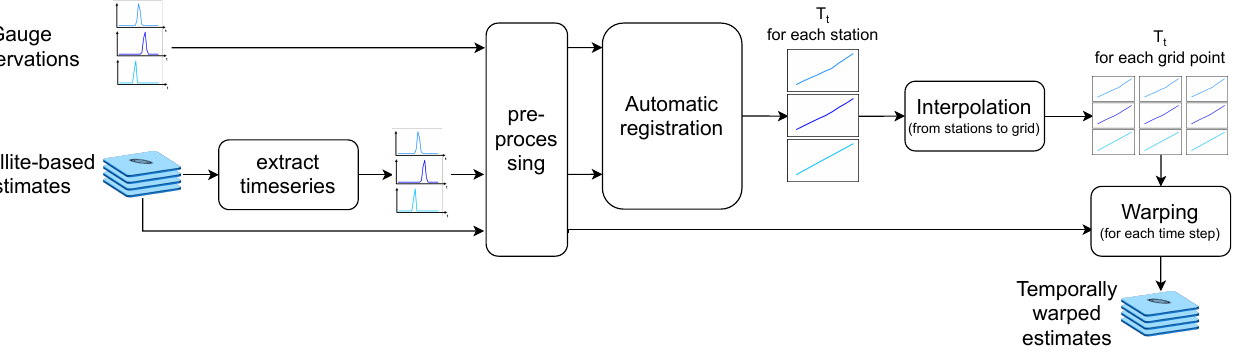
Figure 2. Flowchart of the time warping